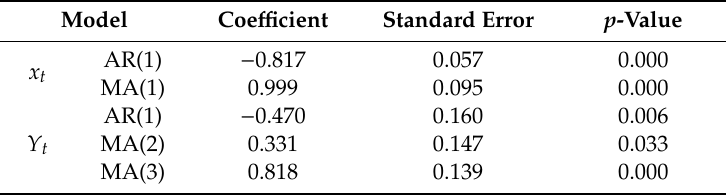
Table 4. Significance tests for the ARIMA model for T HS .